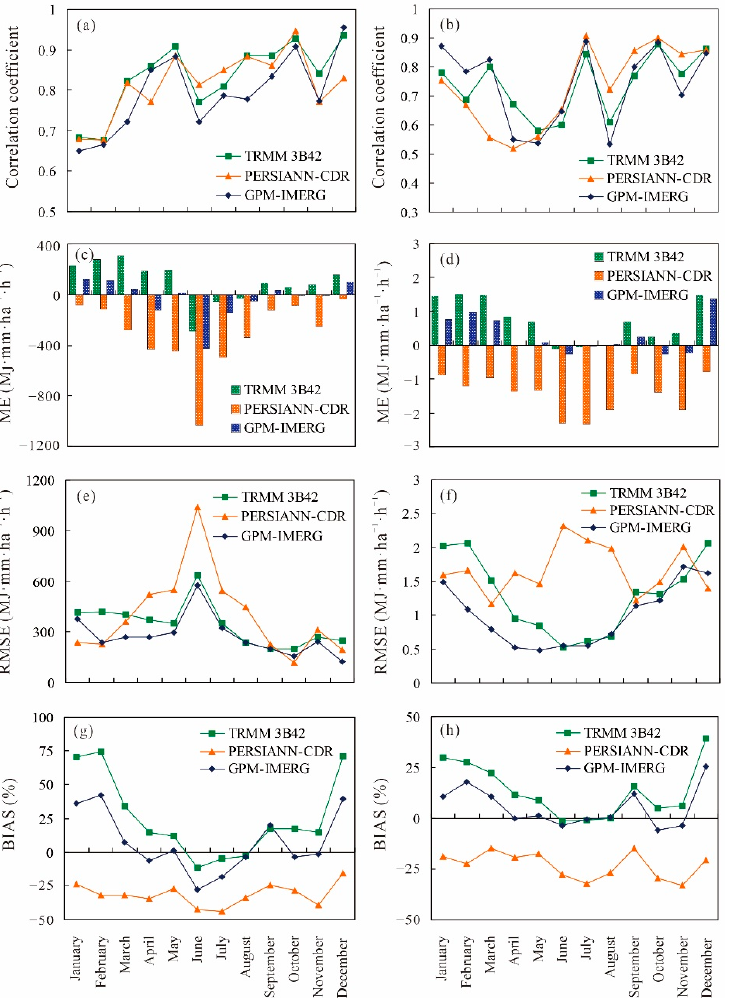
Figure 2. Monthly variation of the R, ME, RMSE, and BIAS (( a , c , e , g ) for monthly rainfall erosivity; ( b , d , f , h ) for monthly erosivity density).